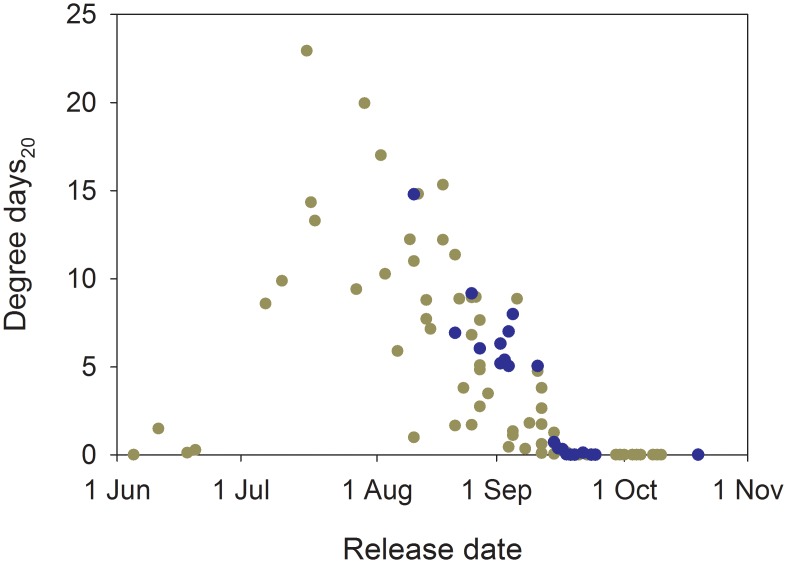
Effect of migration date on acute DD20 accumulation.Relationships between release date and the accumulation of acute temperature exposure measured in degree days ≥20 °C (DD20) for individual fall Chinook salmon (n = 21, blue symbols) and steelhead (n = 75, gold symbols) during their ~470 rkm migration from release to Lower Granite Dam in 2000 and 2002.